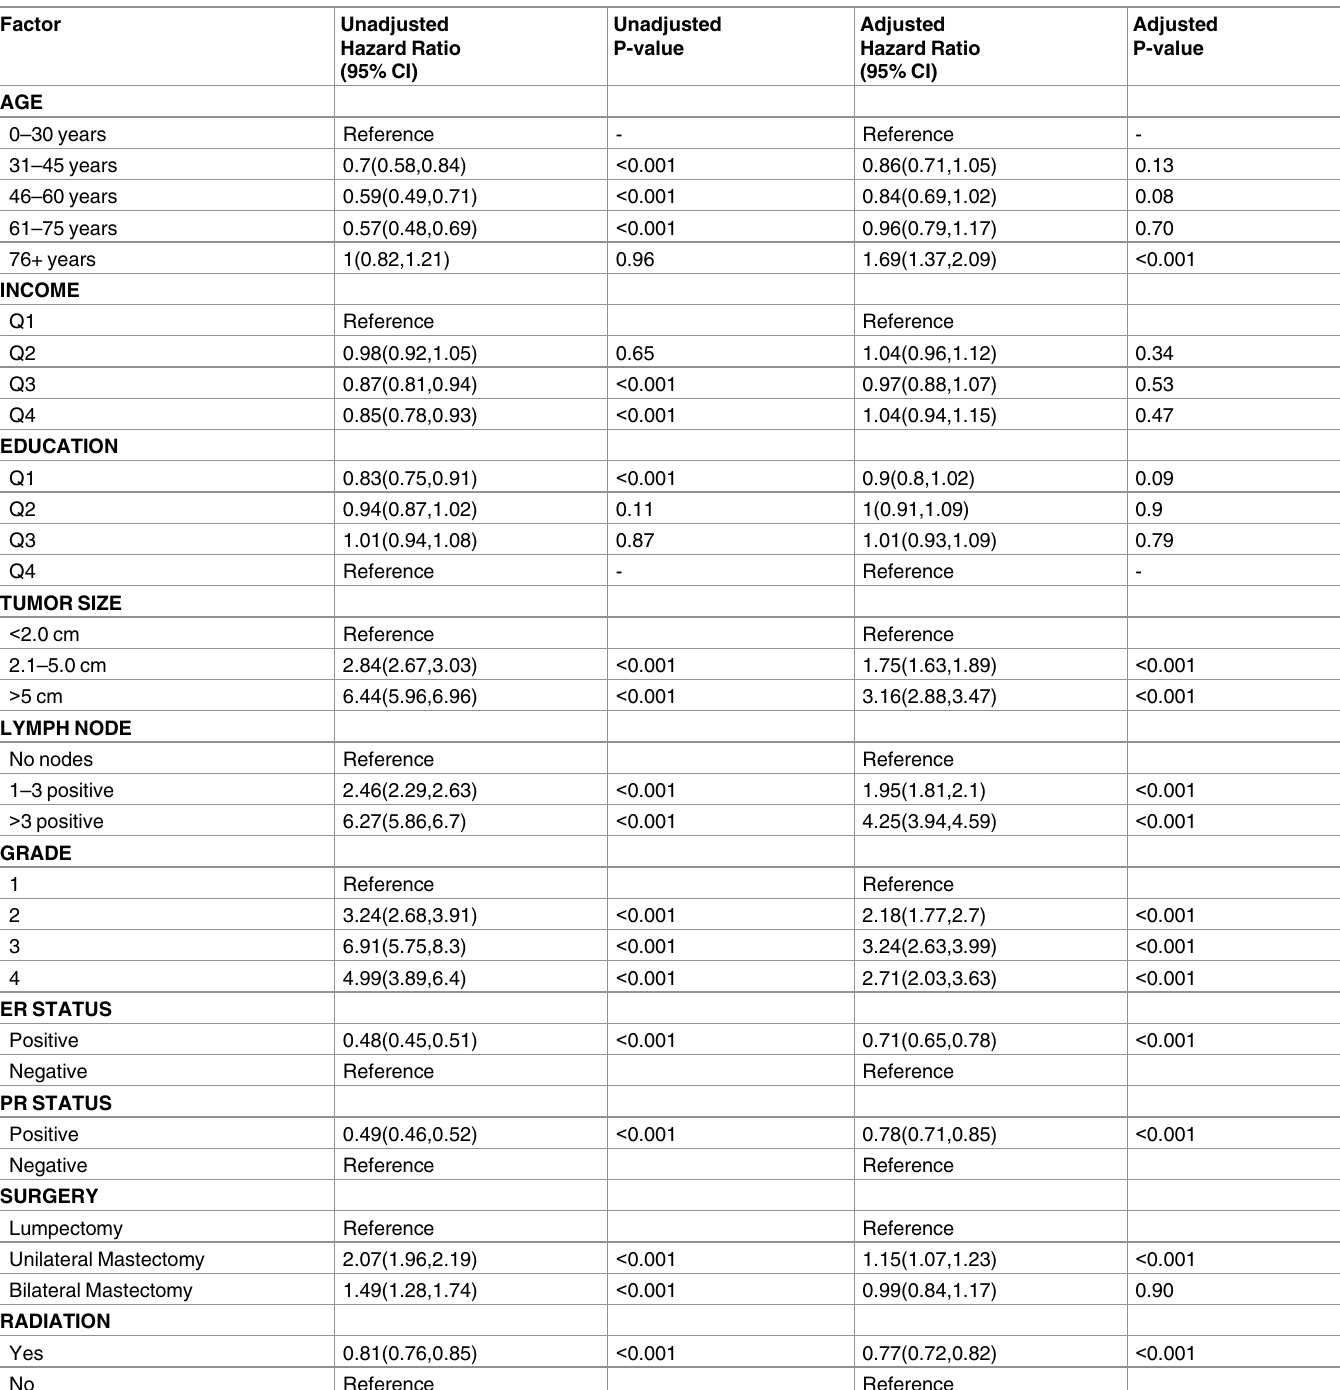
Table 3. Survival analysis of black patients